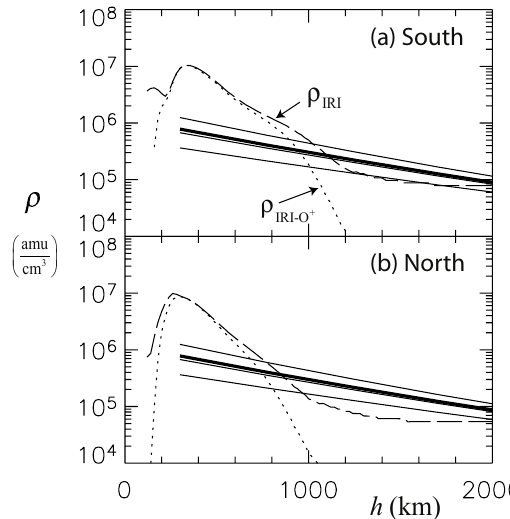
Fig. 18. The solid curves are the same solutions for ρ that were plotted in Fig. 5a and b, but shown with respect to height h from the Earths surface within the southern (a) and northern (b) ionospheres. The large dashed curve is the mass density from the International Reference Ionosphere (IRI) model (Bilitza, 2001). The dotted curve is the mass density from the IRI due to O +